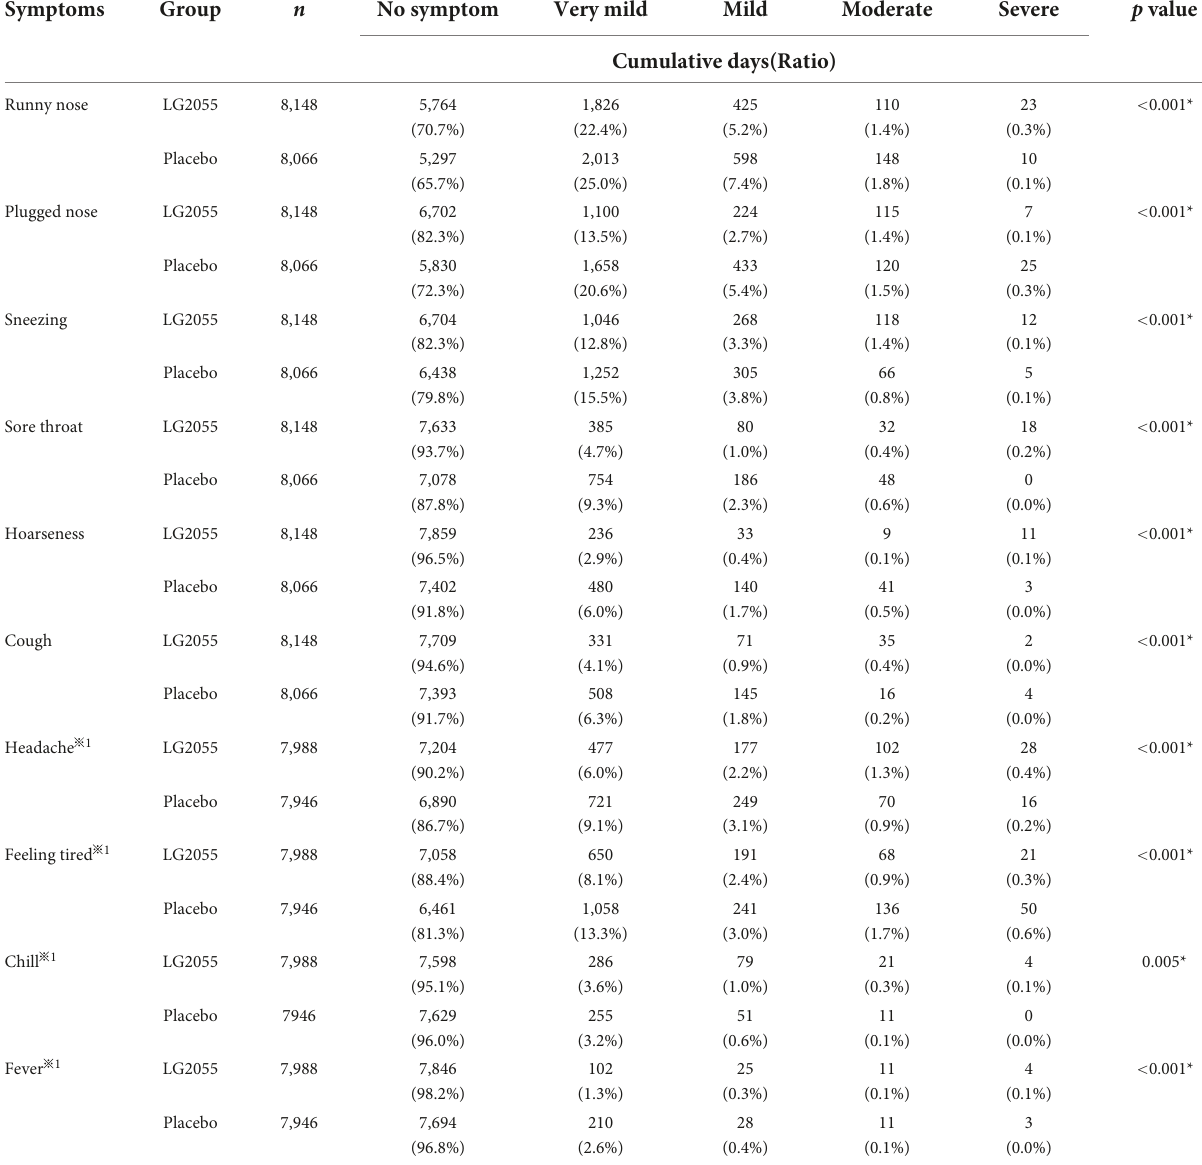
TABLE 2 Comparison of the cumulative days of each symptom (five